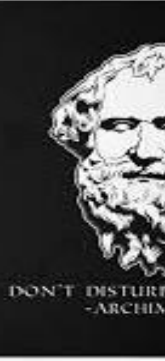
Figure 24. Archimedes.